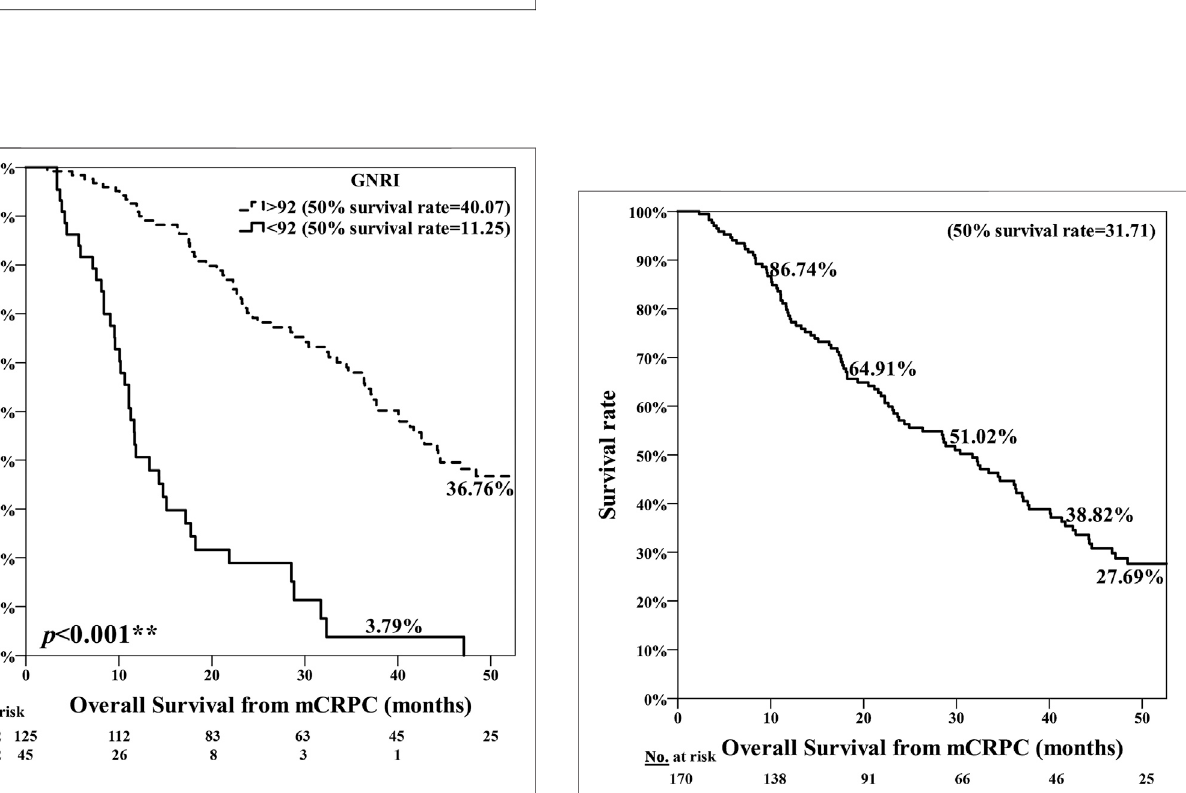
FIGURE 2 | Kaplan-Meier curve for Overall Survival (OS) among the normal nutrition group (GNRI ≥ 92.0) and poor nutrition group (GNRI < 92.0), median 40.07 months vs. 11.25 months, respectively ( p < 0.001**).